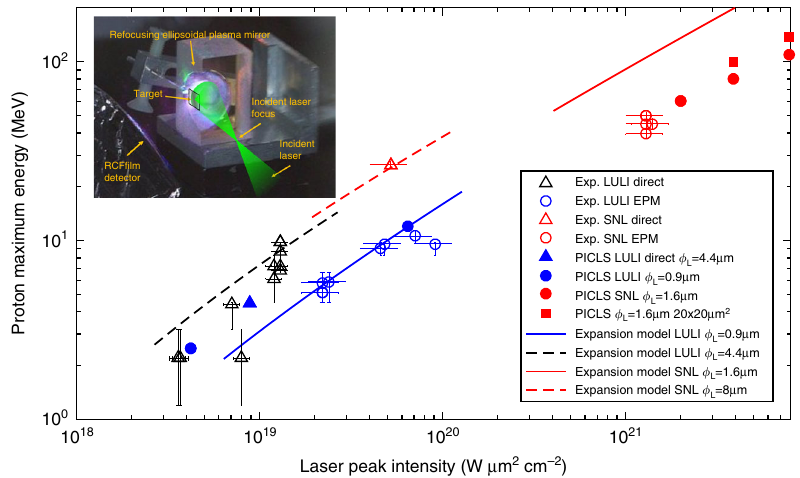
). For the LULI experiments (black or blue open symbols), the targets were Al Fig. 3 Experimental maximum proton energy vs. on-target peak intensity ( I L λ 2 L and Au foils of thickness between 0.5 and 2 μ m and of transverse dimensions > 1 × 1 mm 2 . For the SNL experiment (red open symbols), the targets were 1.1 μ m thick Au foils with transverse dimensions between 50 × 50 μ m 2 and 300 × 300 μ m 2 (note that no trend on the size was observed). Each point corresponds to a single laser shot. Lines plot predictions of the 1D plasma expansion model considered in Figs 1 and 2, and which neglects magnetic fi eld effect (see Methods). Filled symbols represent 2D PICLS simulation results with 2 μ m-thick Al targets: fi lled circles and triangles are for 50 ×50 μ m 2 wide targets and fi lled red squares for 20 × 20 μ m 2 wide targets. The error bars on the proton energy quantify the energy range of the radiochromic fi lms used to diagnose the TNSA protons. The error bars in the laser intensity arise from the uncertainty in estimating the encircled laser energy within the FWHM spot. (inset) Experimental setup employing a refocusing ellipsoidal plasma mirror (EPM) to reduce the laser focal spot and increase the laser intensity